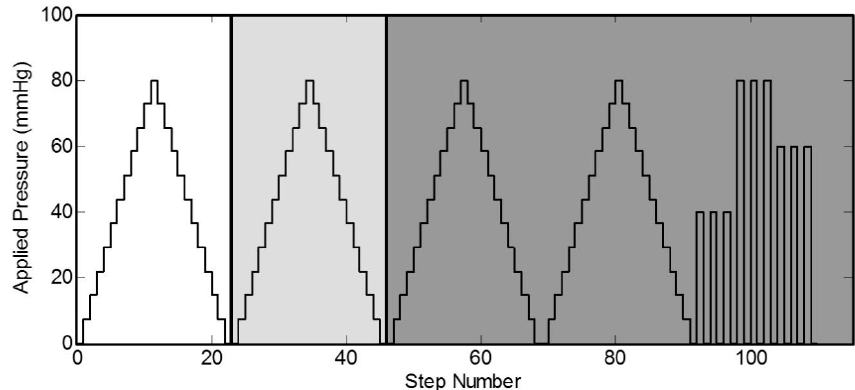
Figure 6. Testing protocol for applied load on sensor in the static tests.